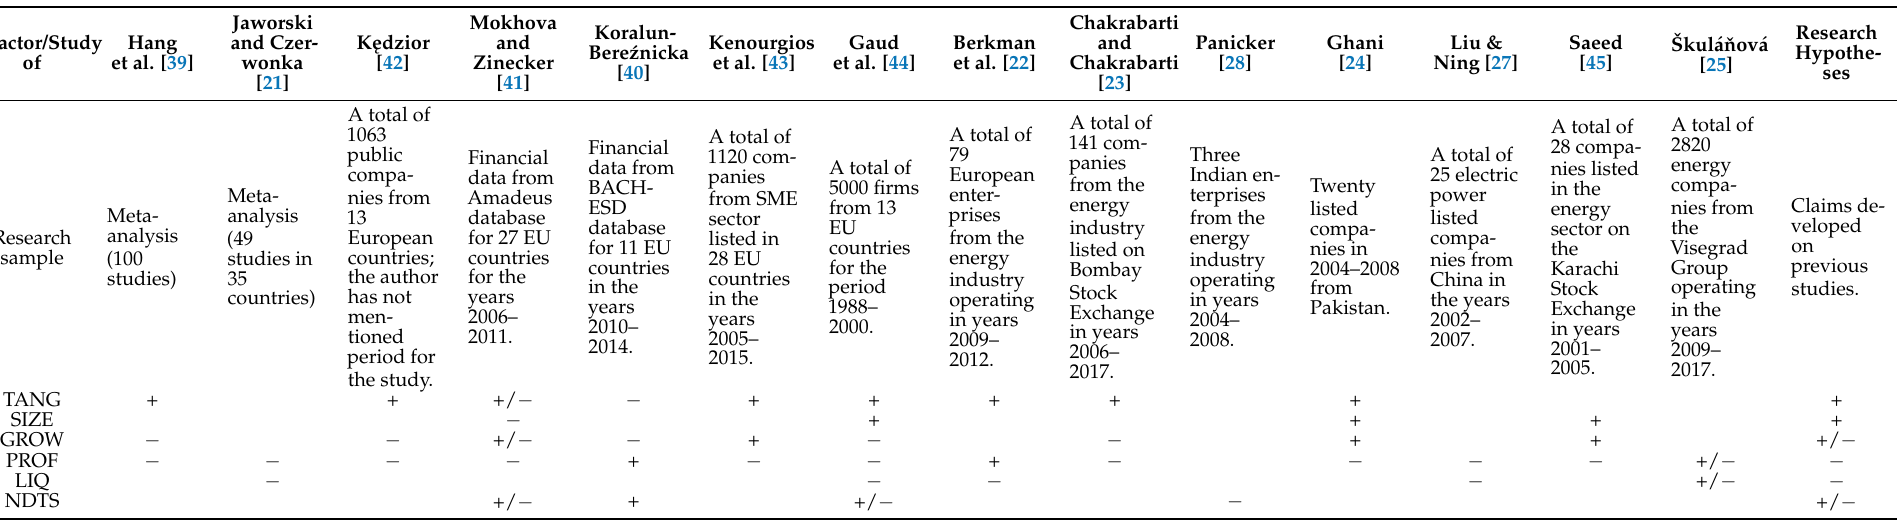
Table A1. Significant influence of firm-specific factors on indebtedness of enterprises according to selected